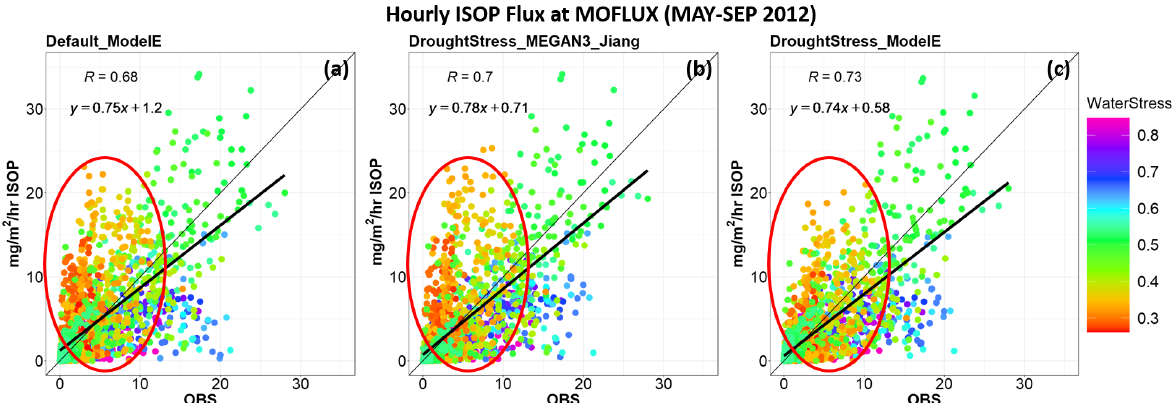
Figure 2. Scatterplots (a) – (c) show hourly simulated isoprene emissions compared to observed for May–September 2012 at the MOFLUX site (units: mgm − 2 h − 1 of isoprene). Panels (a) – (c) indicate the simulations Default_ModelE, DroughtStress_MEGAN3_Jiang, and DroughtStress_ModelE, respectively. The hourly averaged points are color-coded by water